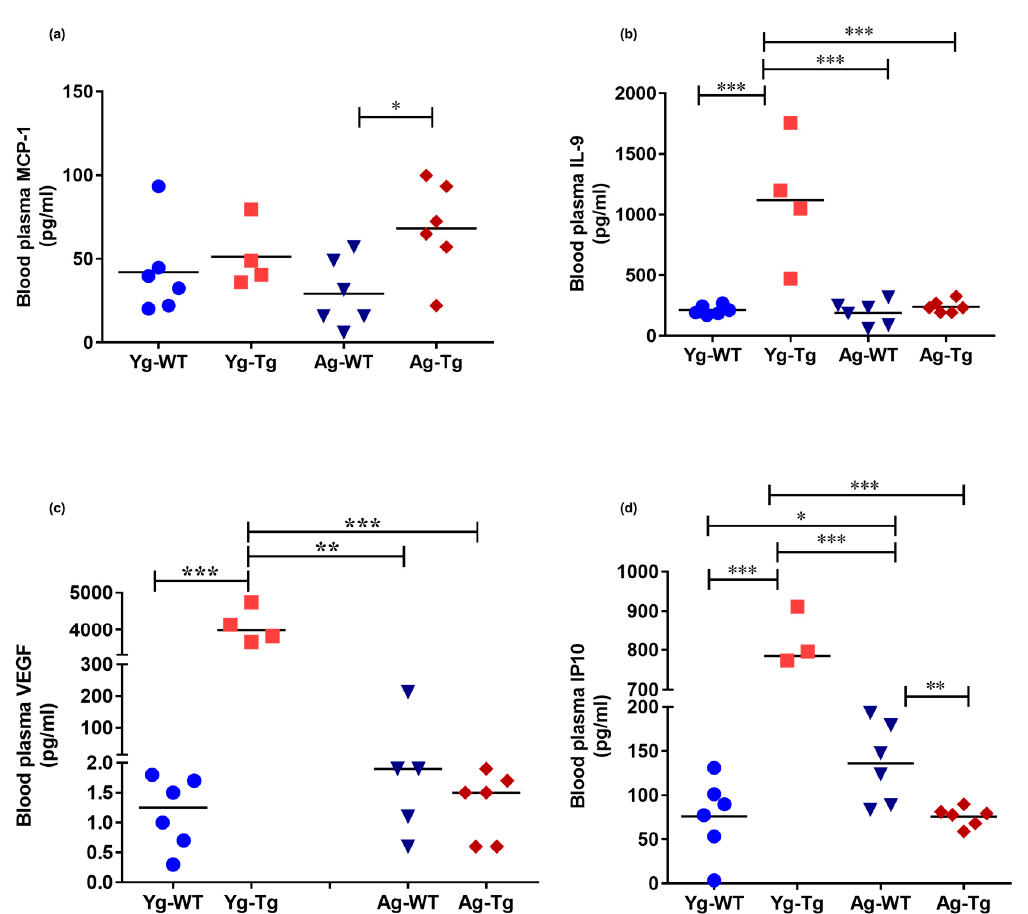
Figure 4. Elevated levels of inflammatory and angiogenic cytokines in the peripheral circulation of pre-symptomatic Tg2576 mice. ( a ) Plasma levels of MCP-1 are significantly elevated at 15 months when cerebral A β pathology is detectible but not at the pre-symptomatic timepoint of 6 months (Yg-Tg) in Tg2576 mice. ( b – d ) Plasma levels of IL-9, VEGF- α , and IP-10 are elevated in the plasma at 6 months in Tg2576 mice (Yg-Tg), prior to any detectible A β in the brain. IL-9, VEGF- α , and IP-10 plasma levels are not significantly elevated at 15 months when significant A β pathology exists in the Tg2576 mice (Ag-Tg) brains. n = 4,6 per group. Data are expressed as mean ± SEM, as well as individual values, and are obtained from three independent experiments at various times. * p < 0.05, ** p < 0.01, and *** p < 0.001. P values were calculated using Two-Way ANOVA with Sidak’s multiple comparisons correction ( a – d